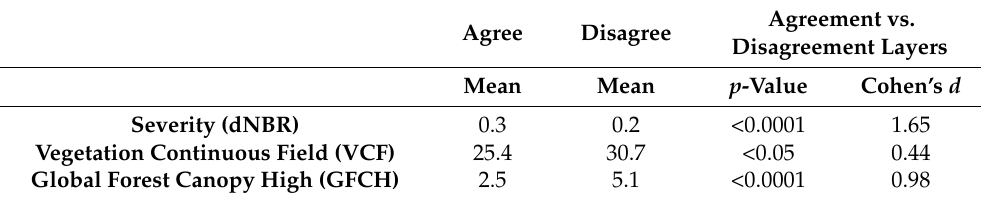
Vegetation Continuous Field